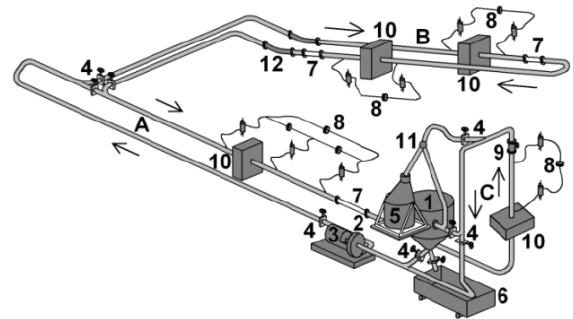
Fig. 1. Experimental test loop D = 100 mm (IH CAS, v. v.